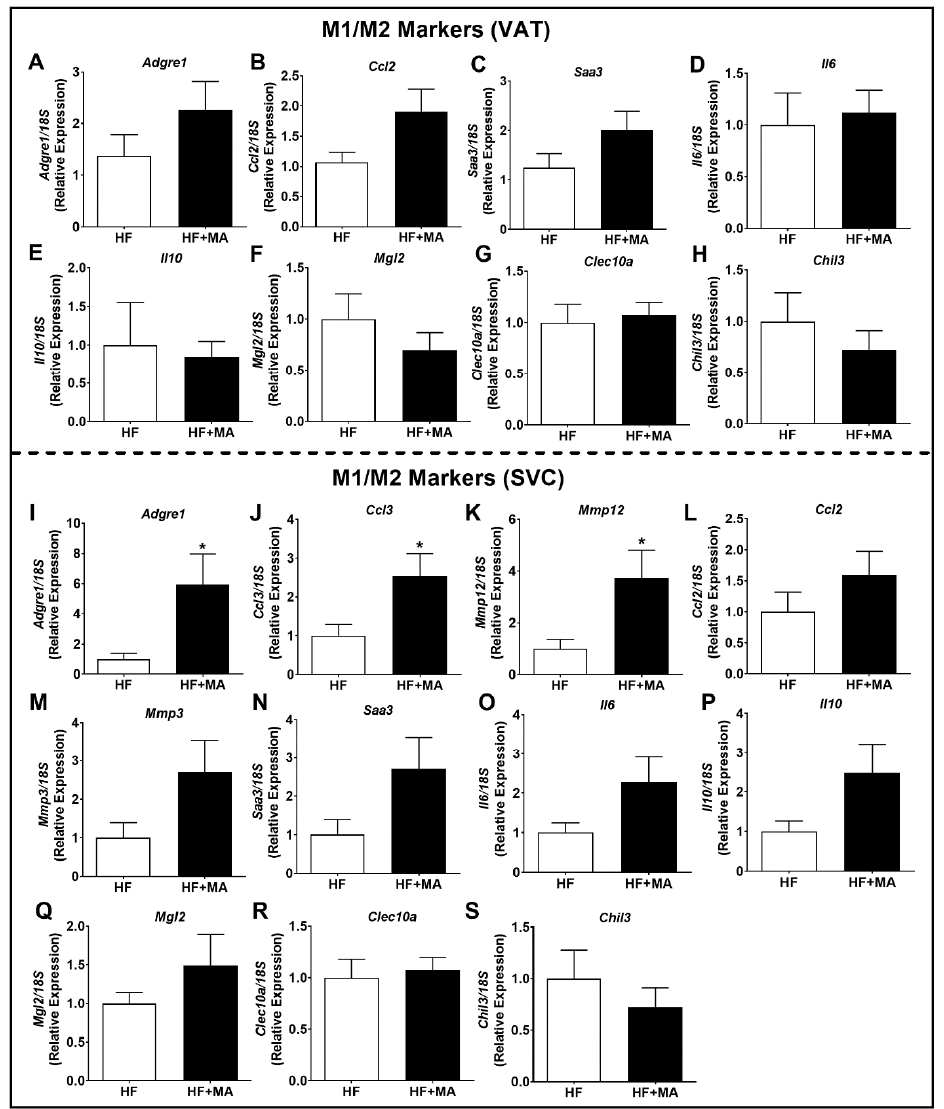
Figure 4. Effect of dietary myristic acid on M1 and M2 markers in VAT and VAT-derived stromal vascular cells. Real-time PCR analysis was performed in the VAT for the mRNA levels of Adgre , a macrophage marker ( A ), other inflammatory genes ( B – D ), and M2 markers ( E – H ). Stromal vascular cells from the VAT were isolated and real-time PCR analysis was performed for macrophage ( I ) and inflammatory markers ( J – O ) as well as M2 markers ( P – S ). Values are expressed as mean ± SEM of 7–8 samples in each group. * p < 0.05 vs. HF. VAT, visceral adipose tissue; HF, high fat; HF+MA, high fat + myristic acid; SVC, stromal vascular